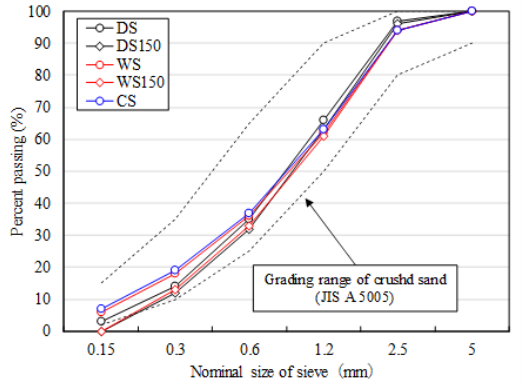
Figure 3. Grain size accumulation curve of crushed stone powder